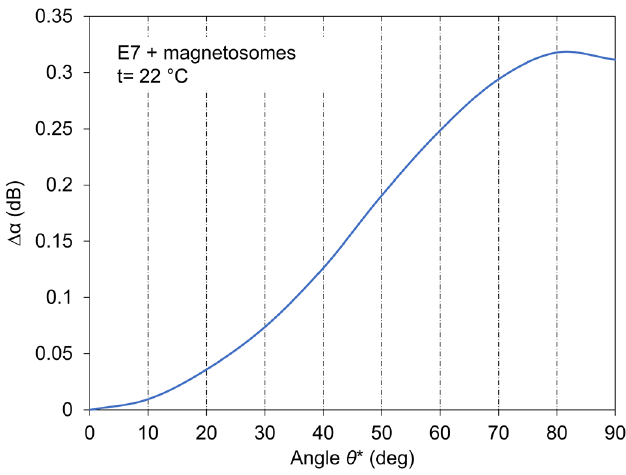
Figure 12. Angle dependence (anisotropy) of SAW attenuation measured at B = 300 mT for E7 doped with magnetosomes.